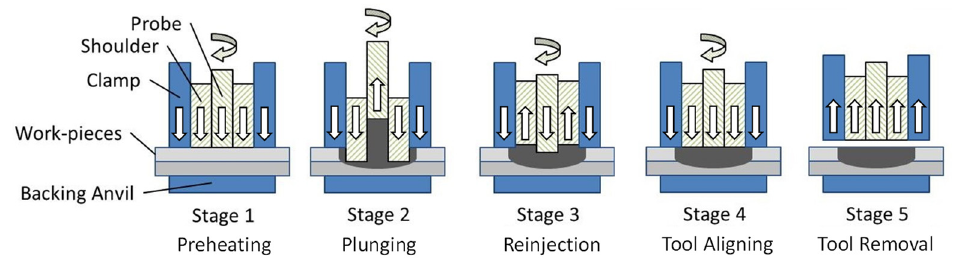
Figure 1. RFSSW process stages.